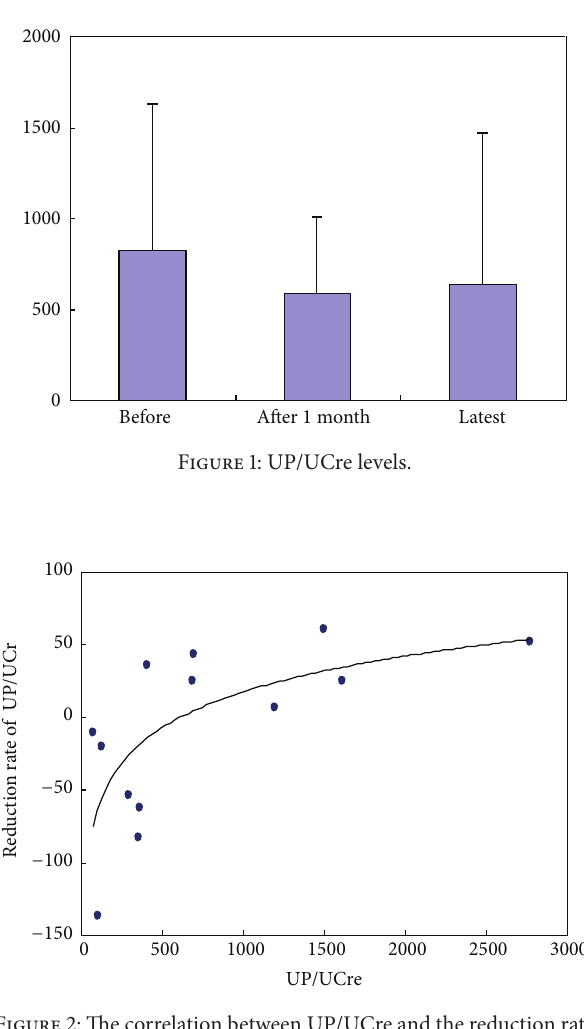
Figure 2: The correlation between UP/UCre and the reduction rate of